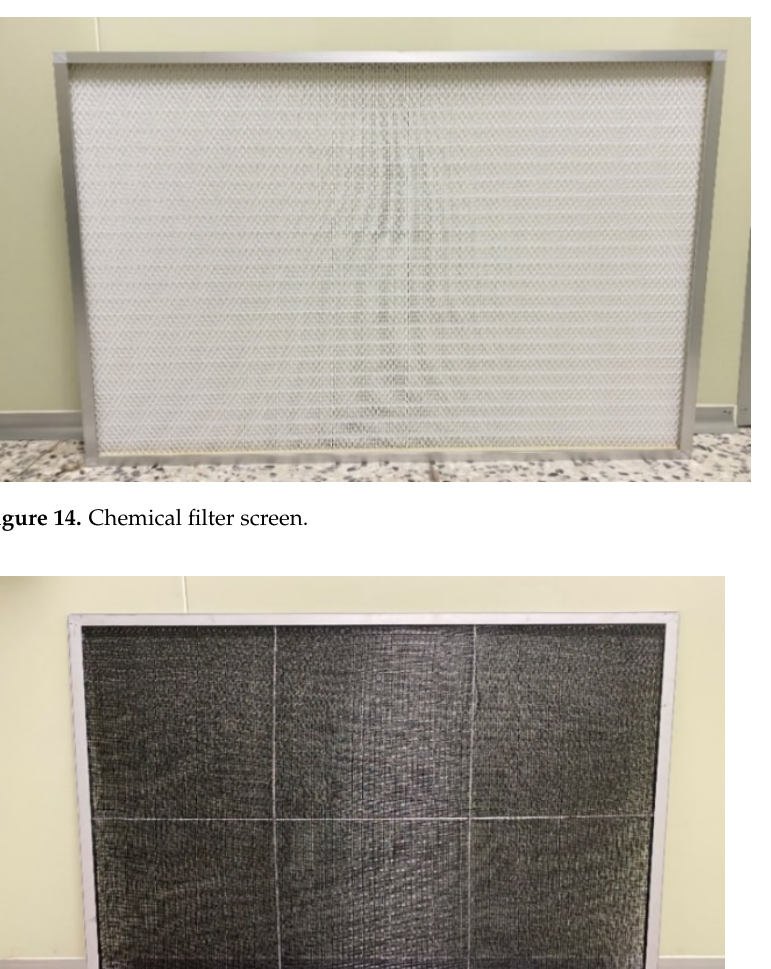
Figure 13. High-efficiency medical sterilization filter screen.